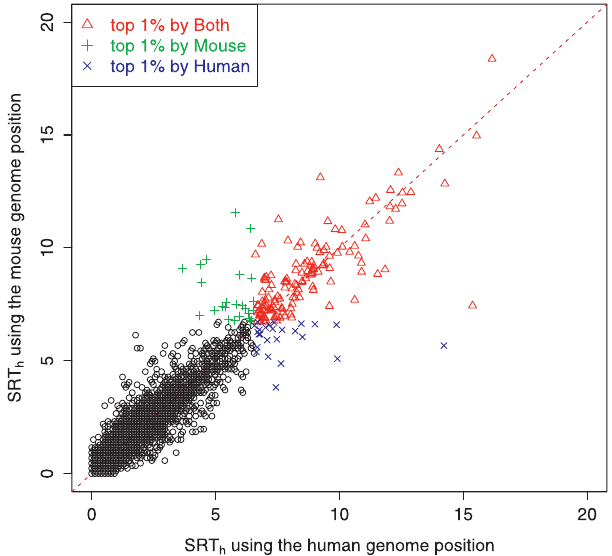
Figure 3. Robustness of the SRT Test (SRT h ) to the Definition of Windows Used for Estimating the Null Tree Shape The SRT h values for amniotic CNCs were computed separately based on windows defined using the human genome position ( x -axis) and the mouse genome position ( y -axis). Signals that are in the top 1% by both window definitions are shown in red. Eight outliers above 20 were removed from the plot. The overall concordance between the two datasets implies that changes in synteny between human and mouse do not greatly disrupt our sliding window estimation procedure.